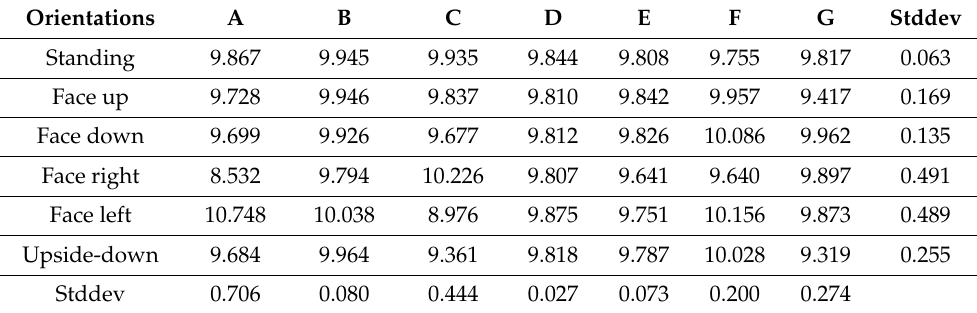
Table 2. Gravity measurements for sample Android devices and 6 different